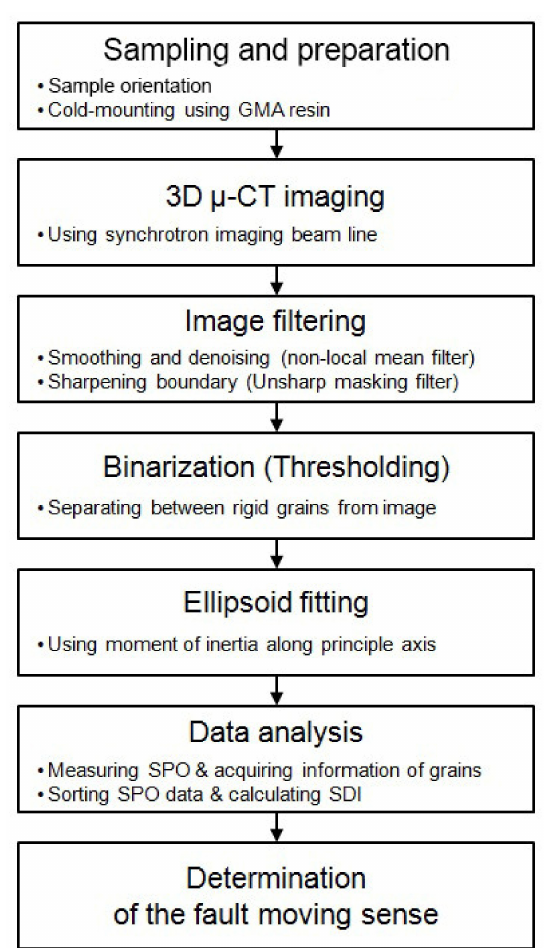
Figure 2. Flow chart showing the entire process of the newly developed 3D-shape preferred orientation (SPO) method to determine the fault motion sense. The method involves seven steps with from oriented sampling for SPO